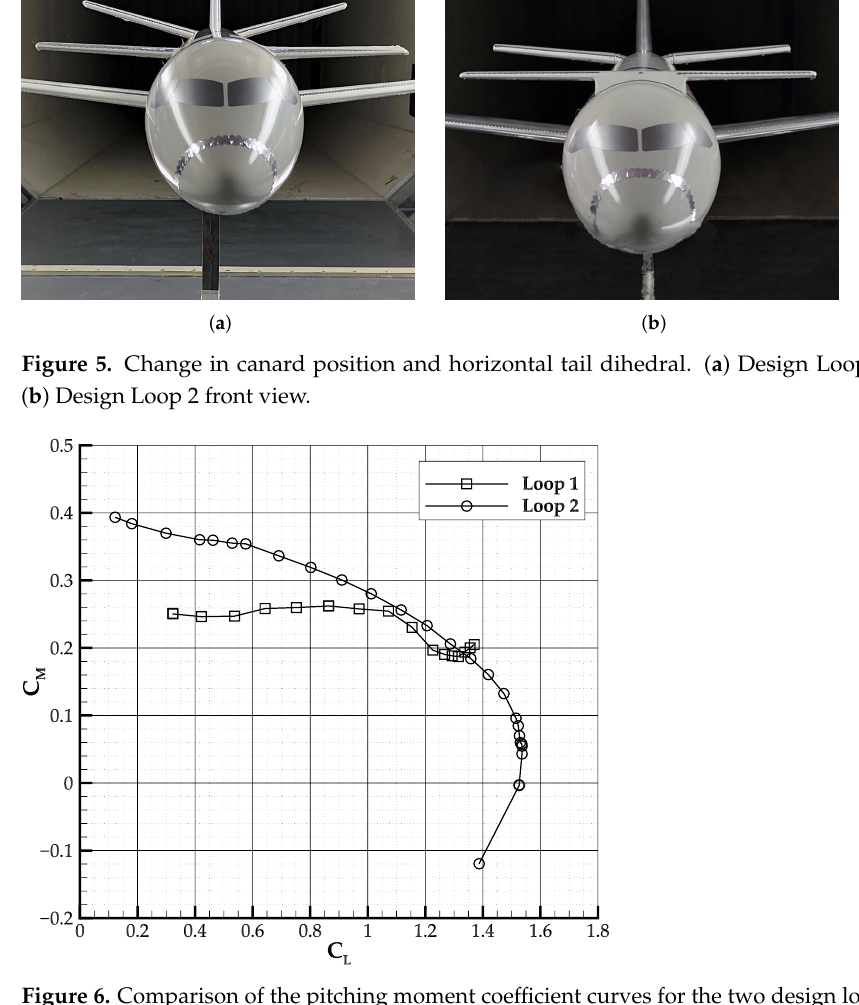
Figure 6. Comparison of the pitching moment coefficient curves for the two design loops. Reference point at x CG = 0, V = 35m/s, Re =